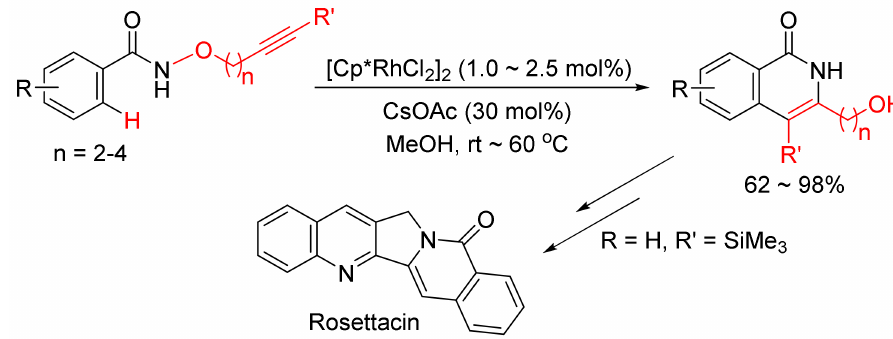
Scheme 7. Synthesis of